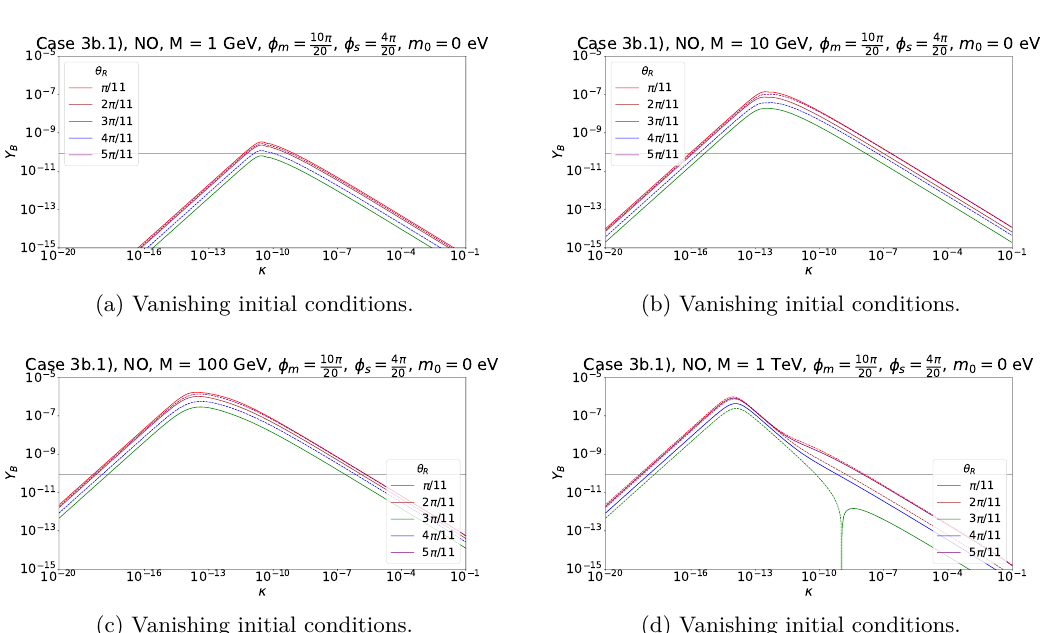
Figure 36 . Case 3 b.1) Y B as function of the splitting κ for a Majorana mass M = 1 GeV (upper left plot), M = 10 GeV (upper right plot), M = 100 GeV (lower left plot) and M = 1 TeV (lower right plot). For each of these choices, different values of θ have been studied. The group theory R parameters are set to n = 20 , m = 10 and s = 4 . Light neutrino masses have strong NO. For the rest of the choices see figure